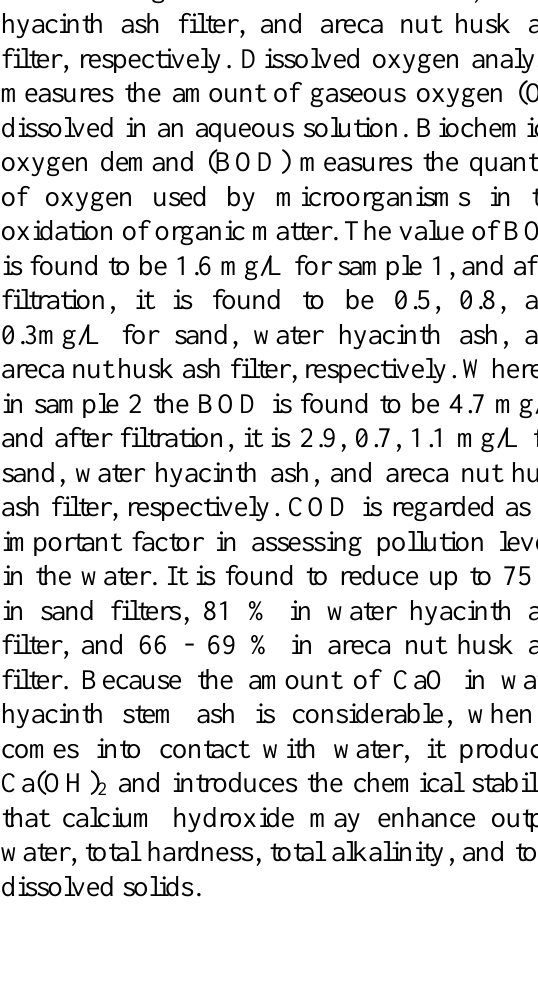
Table 5. Physiochemical parameters of the samples and filtered water